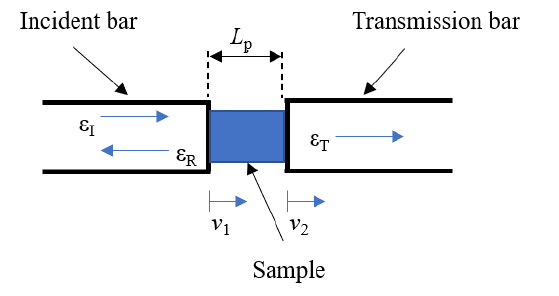
Figure 2. Schematic of the spread of the waves inside the bars. The strain rates were measured using strain gauges attached to the incident and transmission bar; see Figure